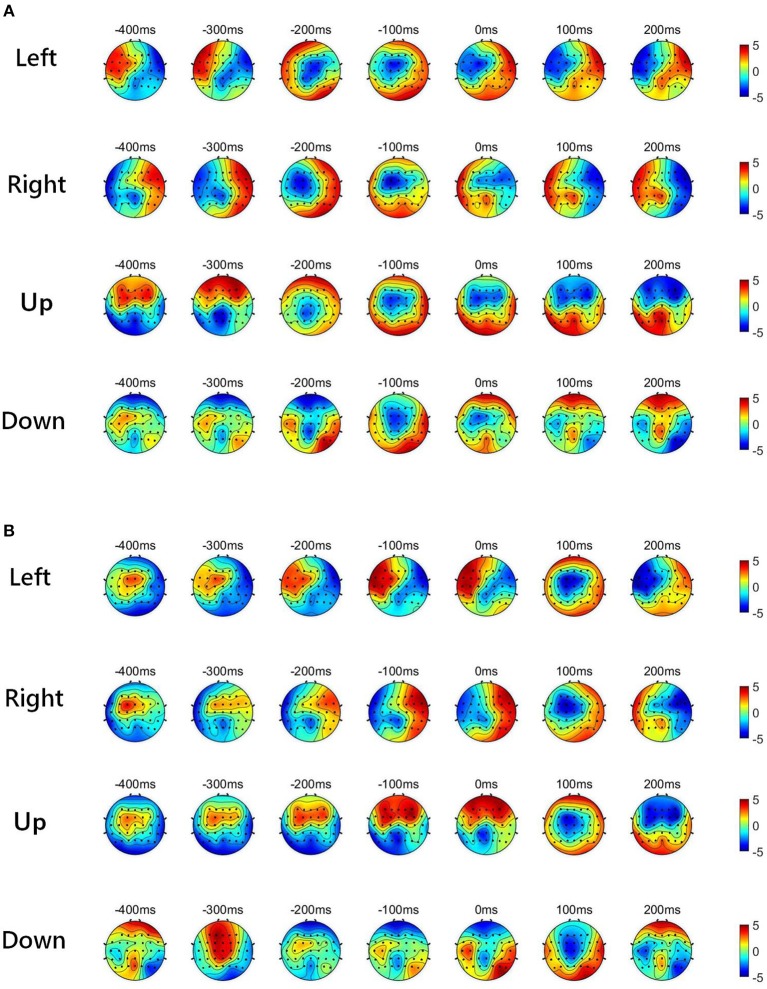
The time-resolved topographical maps of the low-delta EEG features during the four-direction movements from a representative subject and session (1st trial in the 2nd session of subject 5). (A) The low-delta EEG amplitude features. (B) The low-delta EEG phase features.